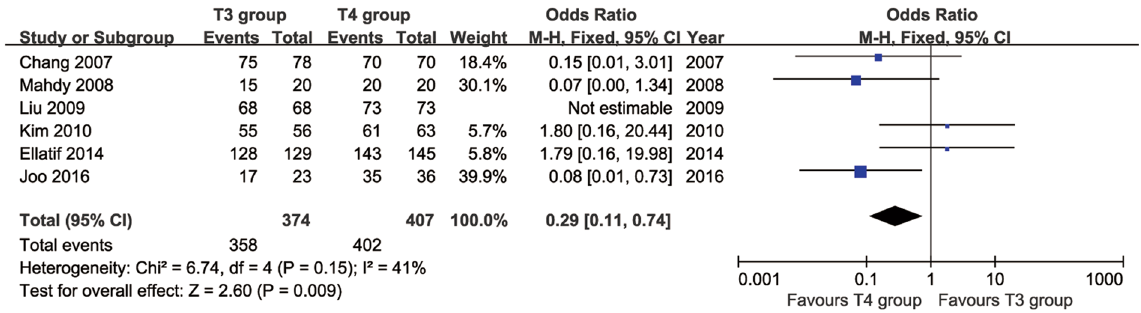
Figure 5. Forest plot for patient satisfaction in the T3 and T4